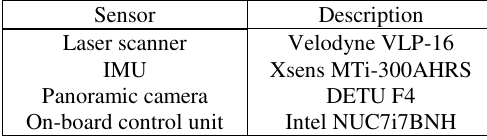
Table 1. Sensor specifications